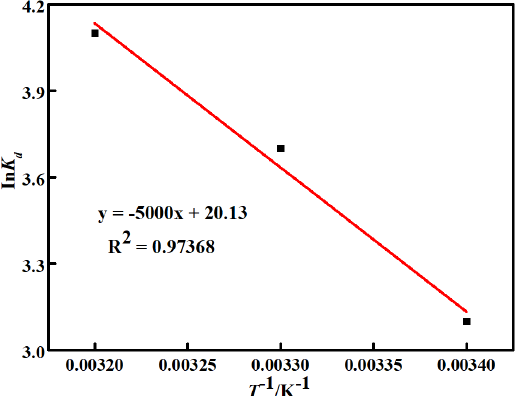
Figure 7. The Cd 2+ adsorption capacity Q e ( a ) and adsorption efficiency ( b ) of the carbonized ZIF−8@PAN nanofiber membrane at various adsorption temperatures and pH = 6.5.